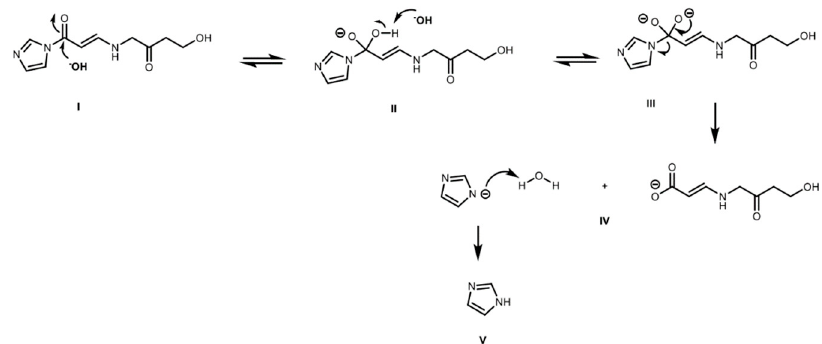
Figure 9. Base catalyzed hydrolysis of CAI: (I) Nucleophilic attack of hydroxyl to carbonyl group of CAI; (II) hydroxyl deprotonation and protonation of tertiary nitrogen; (III–IV) configuration of carboxyl group and elimination of imidazole ring; and (V) protonation of imidazole.